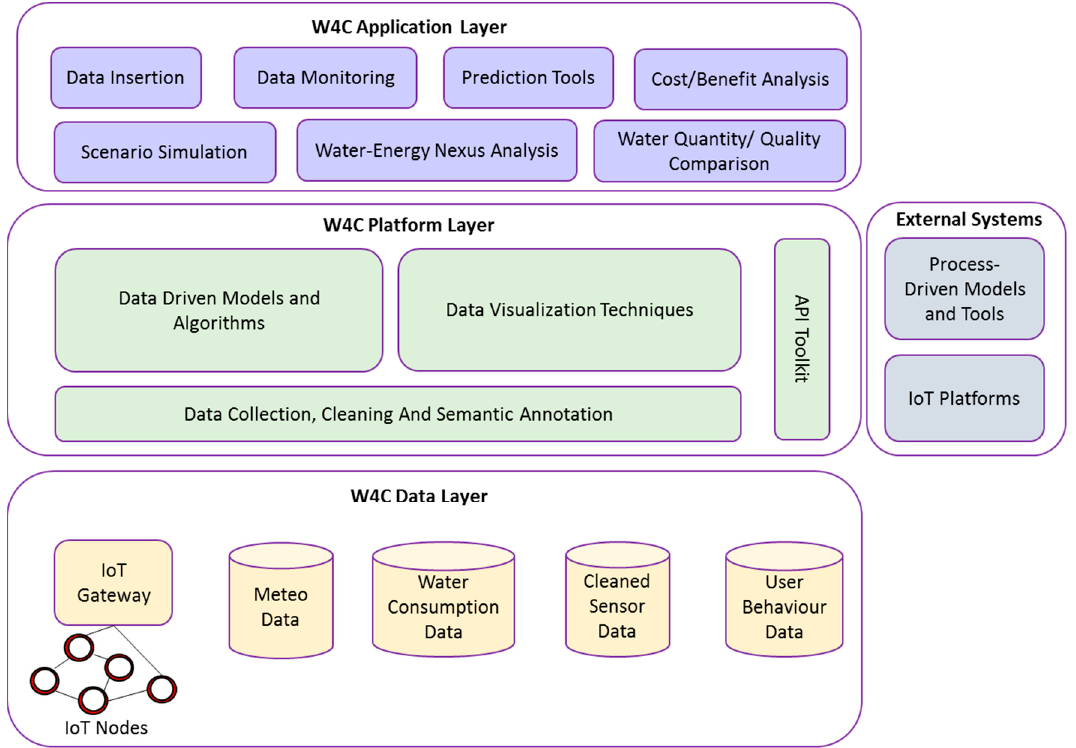
Figure 1. High Level Water4Cities System